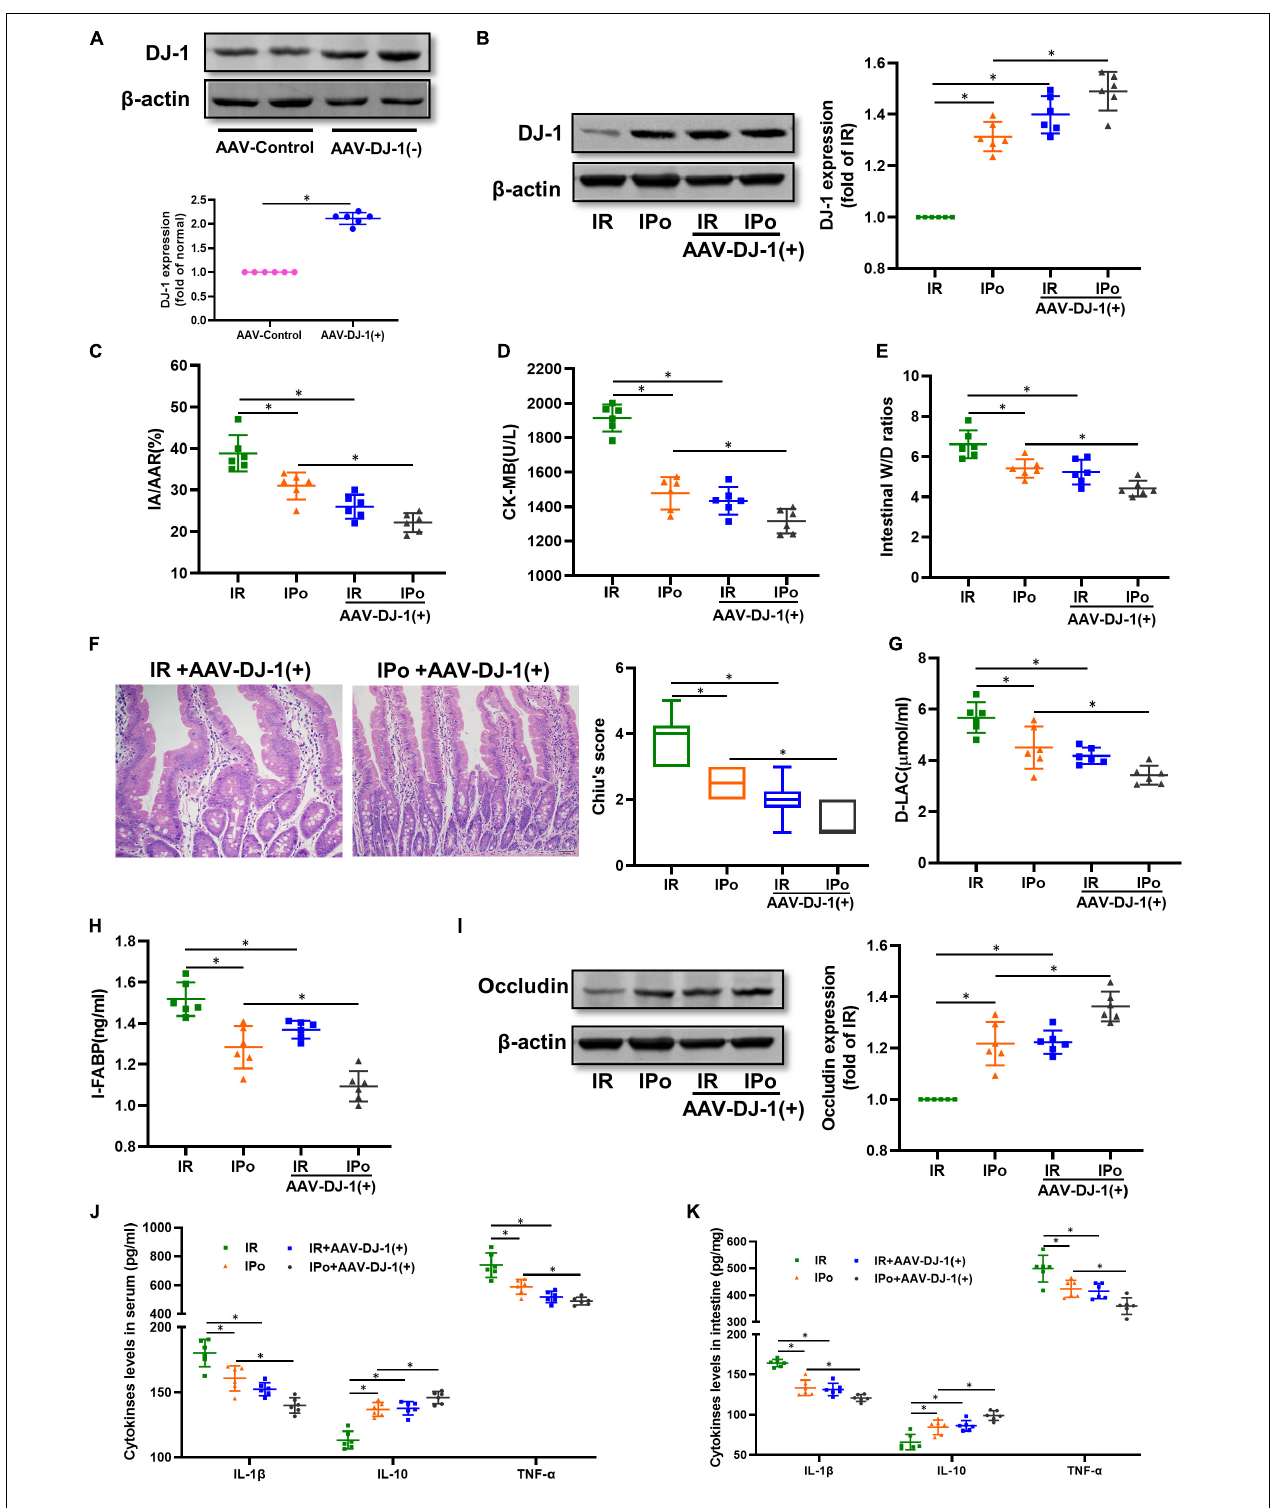
FIGURE 5 | Overexpression of DJ-1 promoted IPo-induced protection against myocardial IR-induced intestinal injury. (A,B) Expression of DJ-1 level. (C) Infarct area relative to the area at risk (IA/AAR × 100%). (D) serum CK-MB level. (E) Intestinal water W/D ratios. (F) Histopathologic changes of the small-intestinal mucosa under light microscopy imaging (H&E staining, Scale bar = 300 µ m). Intestinal mucosa injury was graded by Chiu’s score. Serum concentrations of D-LA (G) and I-FABP (H) . (I) Expression of occludin. The levels of inflammatory cytokines (IL-1 β , IL-10, and TNF- α ) in the serum (J) and intestine (K) . β -actin was detected as loading control. S, Sham; IR, ischemia reperfusion; IPo, ischemic postconditioning. Data are mean ± SD or Box-Whisker’s plot ( n = 6); * P <